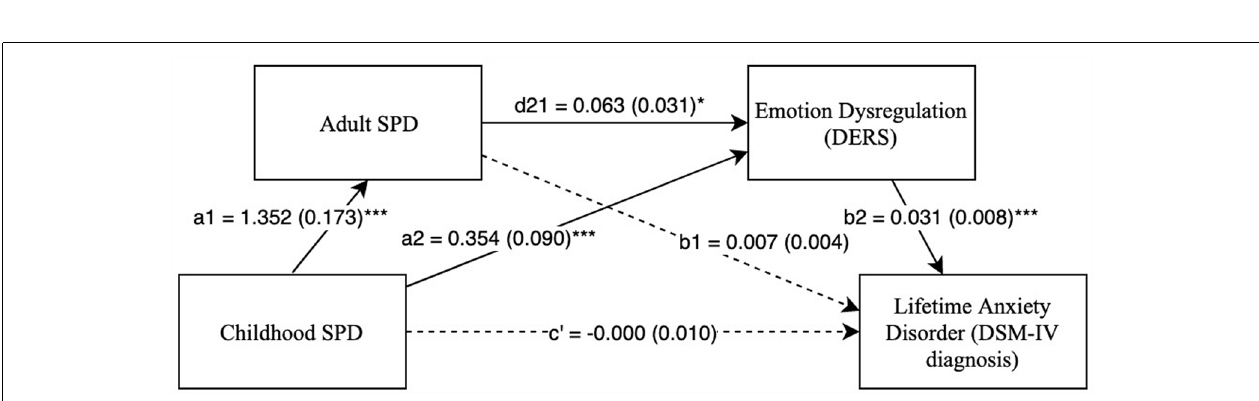
FIGURE 2 | Childhood SPD predicting lifetime anxiety with adult SPD as mediator 1 and emotional dysregulation as mediator 2. Note: ∗ p < 0.05, ∗∗∗ p < 0.001. Standard errors are in parentheses, solid lines represent significant indirect paths, a1 = unstandardized regression coefficient for the IV predicting the mediator 1, a2 = unstandardized coefficient for the IV predicting mediator 2 with mediator 1 in the model, d21 = unstandardized regression coefficient for mediator 1 predicting mediator 2 with IV in the model, b1 = unstandardized regression coefficient for mediator 1 predicting the DV with IV and mediator 1 in the model, b2 = unstandardized regression coefficient for mediator 2 predicting the DV with mediator 1 and the IV in the model, c (cid:48) = unstandardized coefficient for the IV predicting the DV with both the mediators in the model (indirect effect). SPD, Sensory Processing Disorder symptoms; DERS, Total score on Difficulty in Emotion Regulation Scale; SPDI, Sensory Processing Disorder Interview, version 2. Sex and race are included as covariates in all regression equations, coefficients of covariates are omitted for clarity.